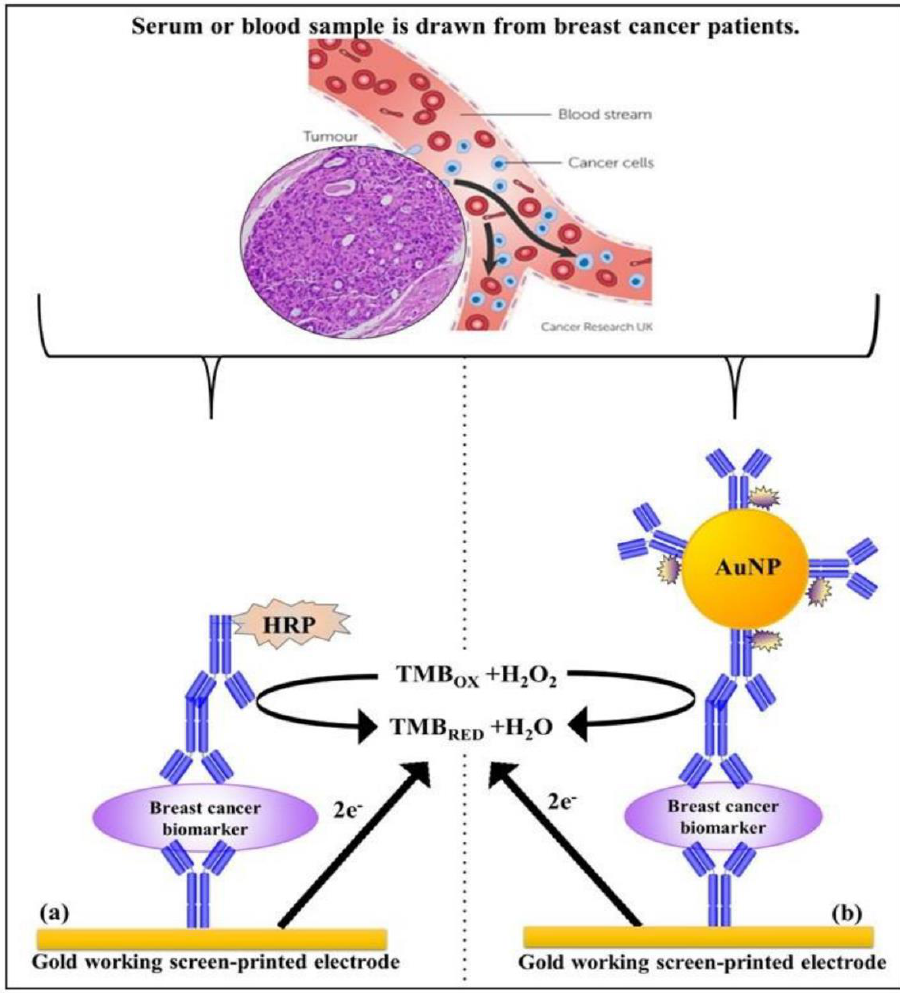
Figure 3. Fabricated chips are shown for the indirect and the indirect AuNPs enhanced sandwich biosensor for HER-1 and HER-2 oncomarkers; ( a ) standard assay and ( b ) AuNP assay [127].